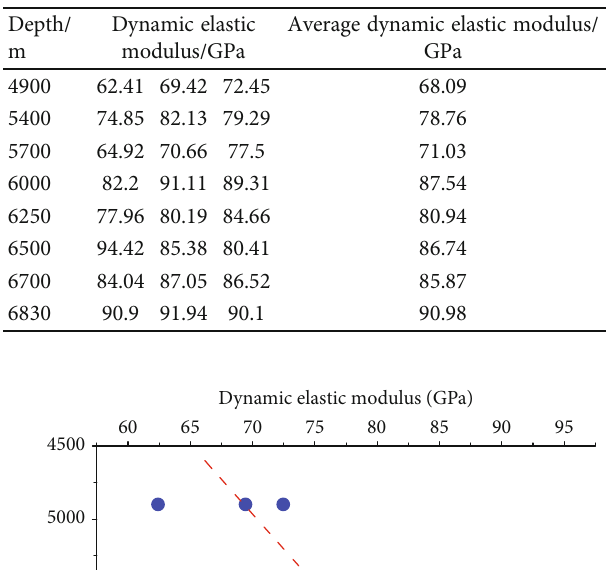
Table 3: Dynamic elastic modulus of rock at di ff erent depths in SK-2.